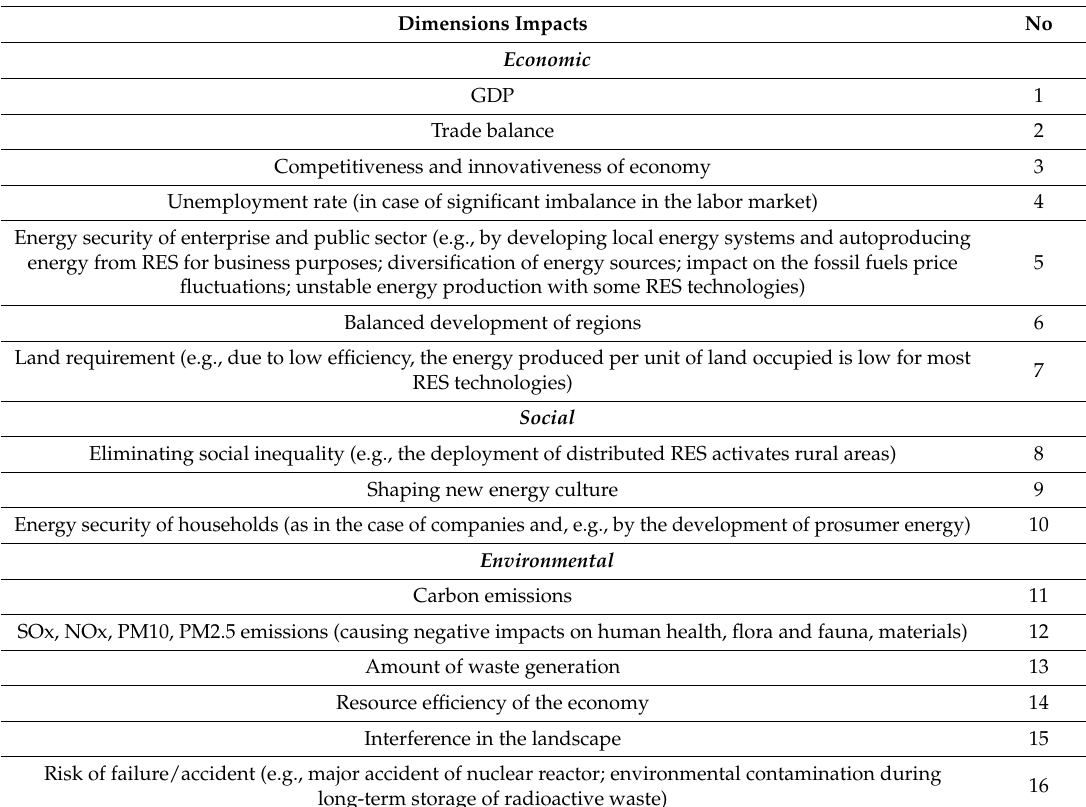
Table 1. Economic, social and environmental impacts of low-emission energy